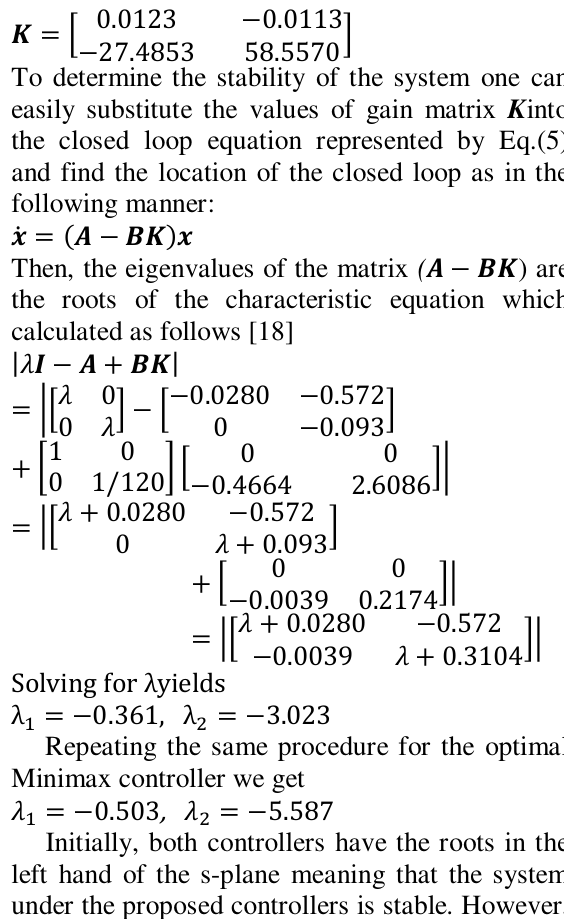
Fig .4. Matlab-Simulink Modeling of Sliding Mode Controller and Optimal